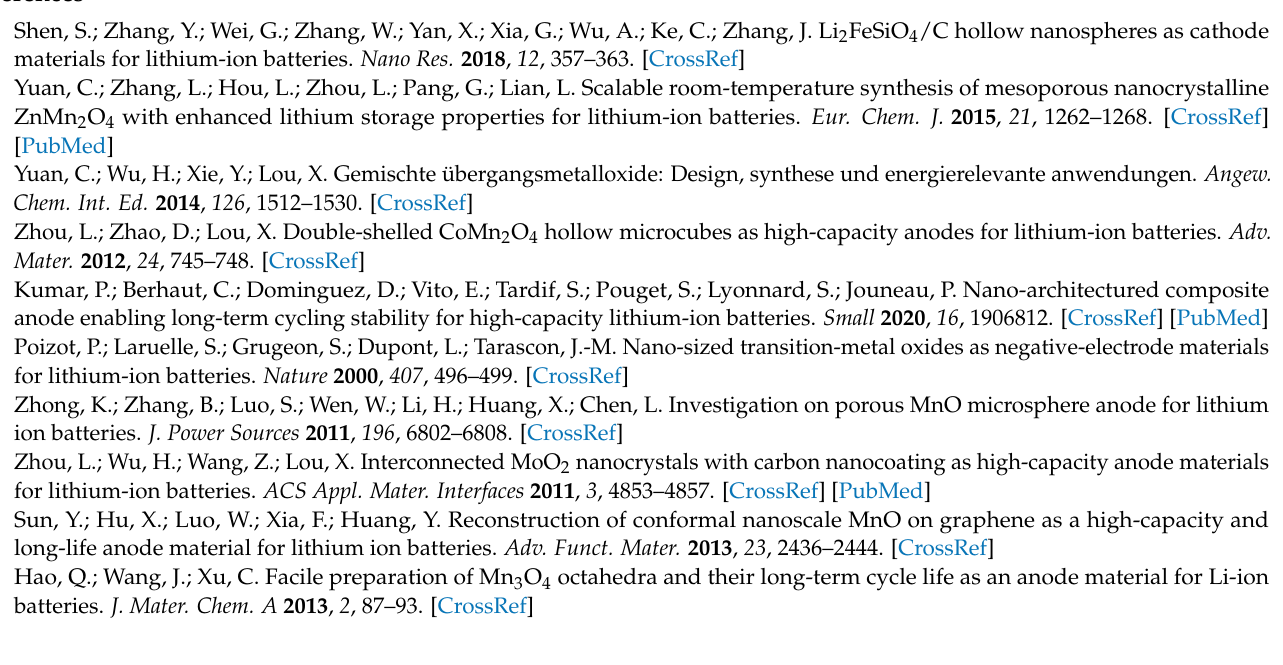
ZnMn 2 O 4 . Table S1: Rietveld refinement results of XRD data for ZMO HMRs samples. Figure S2: ( a , b ) FESEM and ( c , d ) TEM images for the ZnC 2 O 4 -MnC 2 O 4 · 2H 2 O precursor. Figure S3: TG-DSC curves of the ZnC 2 O 4 -MnC 2 O 4 · 2H 2 O precursor. Figure S4: ( a ) Nitrogen adsorption/desorption isotherms and ( b ) pore-size distribution plot of the ZMO HMRs. Figure S5; The XRD pattern of ZMO-AC ( a ) and ( b ) ZMMO-NO. Figure S6: FESEM images of the ZMO-AC: ( a ) precursor, ( b ) after annealing, ( c ) TEM images for after annealing. ZMO-NO: ( d ) precursor, ( e ) after annealing, ( f ) TEM images for after annealing. Figure S7: Typical initial discharge-charge voltage profiles of the ZMO HMRs electrode and corresponding ex-situ XRD analysis at different selected voltages. Figure S8; FESEM image of the ZMO-HMRs cycled over 250 cycles. Figure S9: Cross-section SEM images of ( a ) original pristine ZMO HMRs electrode, ( b ) pristine ZMO HMRs electrode after 250 cycles at 0.5 A g − 1 . Figure S10: ( a ) EIS spectra and ( b ) corresponding equivalent circuit of ZMO HMRs and ZMO-AC. Table S2: Corresponding EIS fitted data for the ZMO HMRs and